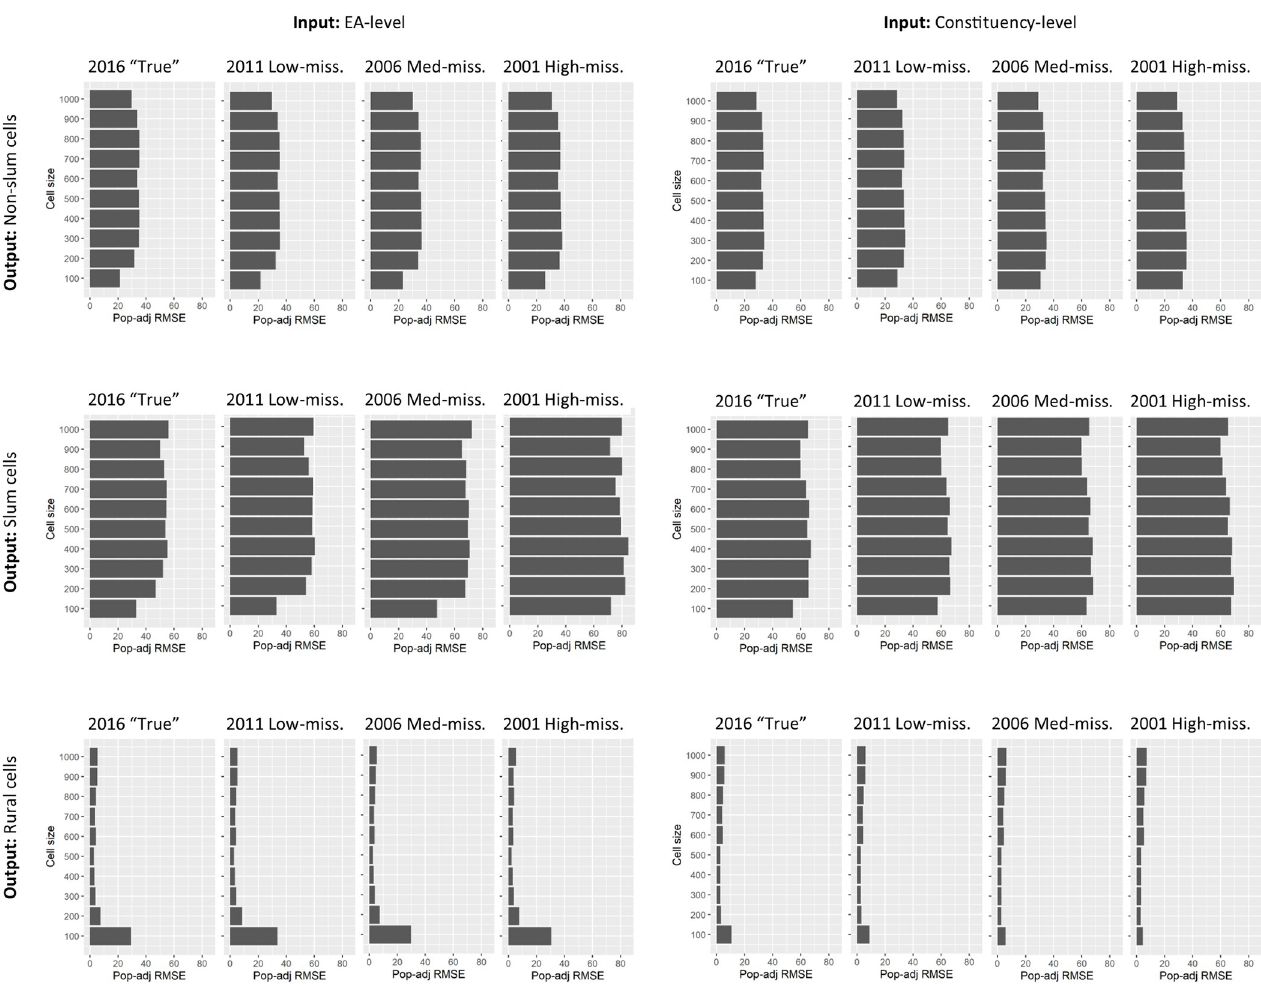
Fig 7. Population density root mean square error (RMSE) per hectare according to input population aggregation, a selection of scenarios, and cell size.